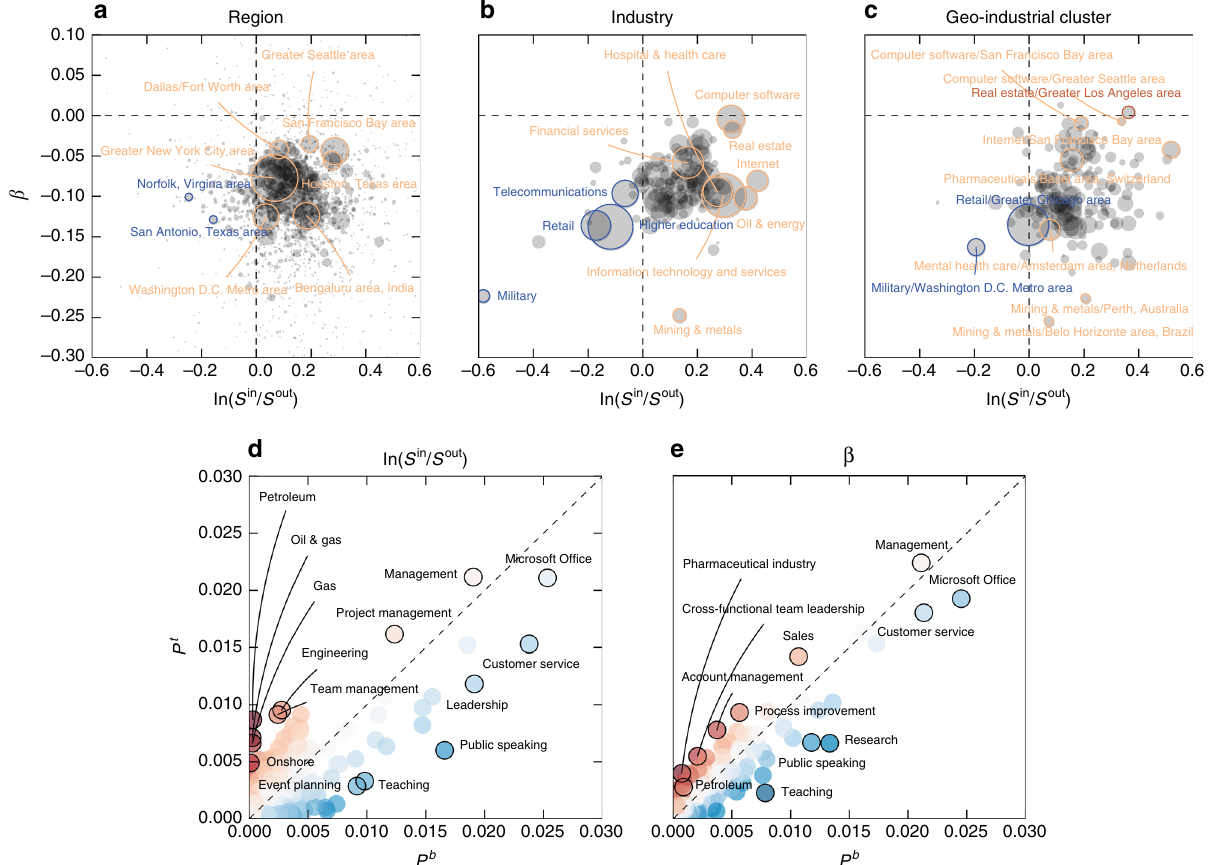
Fig. 5 Growth of regions, industries, and geo-industrial clusters and associated skills in growing and declining geo-industrial clusters. a – c The log-ratio of in fl ux to out fl ux and its growth over time, aggregated by region a , industry b , and geo-industrial cluster c . The amount of growth is calculated by the log- ratio of in fl ux to out fl ux ( log ( S in / S out )) during each year from 2010 to 2014; its linear time trend ( β i ) is estimated by the linear regression coef fi cient of in fl ux ratios to time over this period. The size of a circle represents the number of total transitions either into or out of a corresponding category. d , e Over- represented skills in geo-industrial clusters in the top and bottom quartiles of log-ratio in fl ux to out fl ux d and its linear time trend e . The fraction of people (cid:1) (cid:3) (cid:1) who have a certain skill in the top P t and bottom P b q q